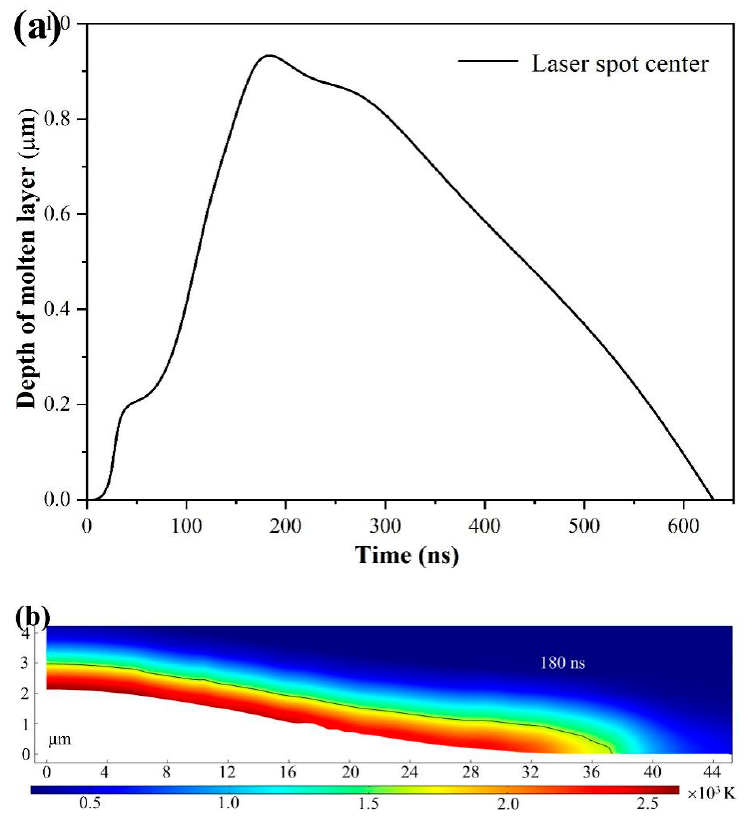
Figure 7. Evolution of simulated molten laser depth for laser spot center with time for laser fluence of 19.3 J/cm 2 ( a ) and the corresponding recast layer plot at 180 ns ( b ).